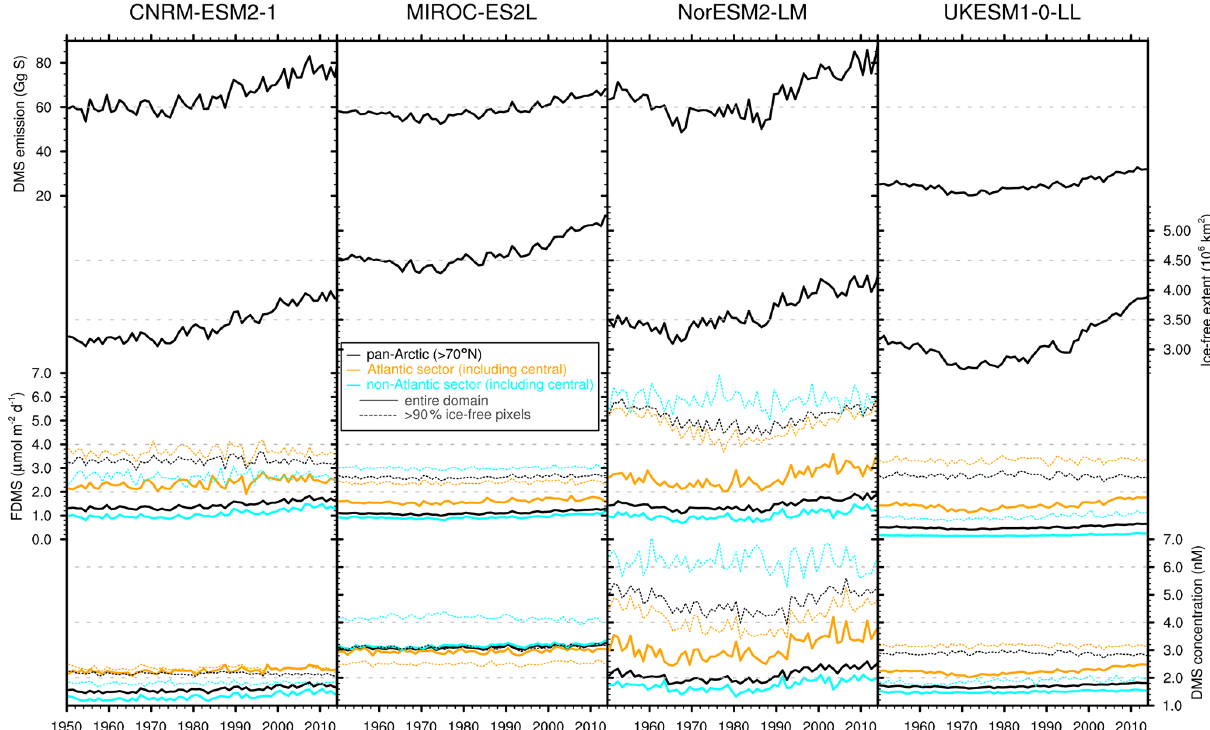
Figure 14. From top to bottom in each column are time series (1950–2014) of May–August values of integrated DMS emission (GgS), mean ice-free extent (10 6 km 2 ), area-weighted mean DMS flux (µmolm − 2 d − 1 ), and area-weighted mean DMS concentrations (nM). The same four months (May to August) and the same regions as those of Galí et al. (2019) are shown for the CMIP6 models in the four columns: black lines for pan-Arctic ( > 70 ◦ N), cyan lines for non-Atlantic sector (including central), and orange lines for Atlantic sector (including central). Solid lines are for values computed from all pixels of a given region. Dashed lines are for DMS fluxes and DMS concentrations computed only from > 90% ice-free pixels of a given region, as in Galí et al. (2019). Grey dotted lines are visual aids to ease the comparison between